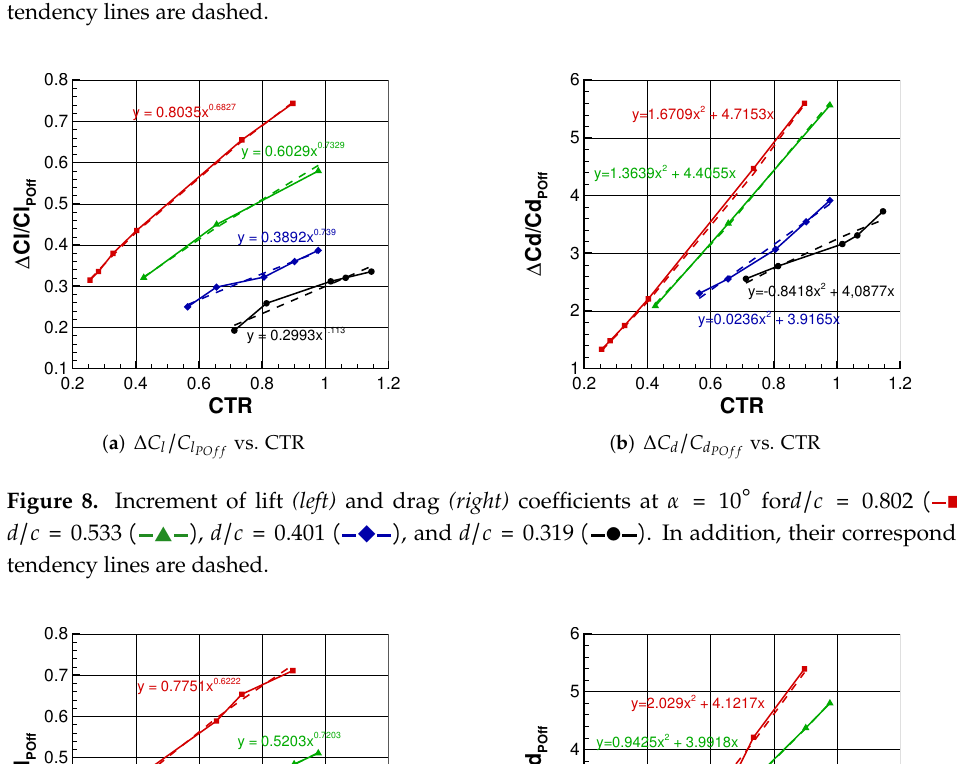
Figure 7. Increment of lift (left) and drag (right) coefficients at α = 8 d / c = 0.533 ( ▲ ) , d / c = 0.401 ( ◆ ) , and d / c = 0.319 ( ● ) . In addition, their corresponding tendency lines are dashed.